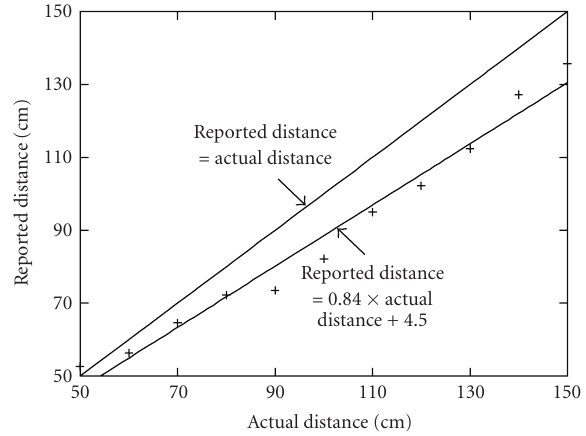
Figure 8: Experimental result of distance to the object and the mean of reported distance